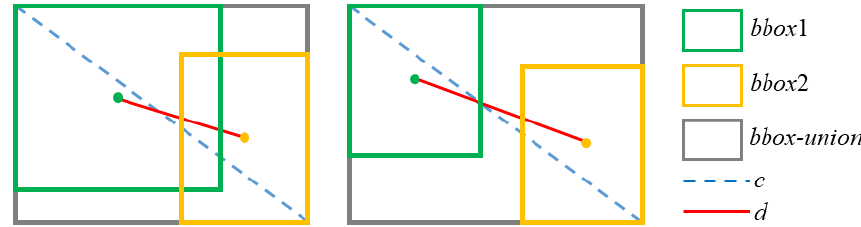
shown in Figure 4.